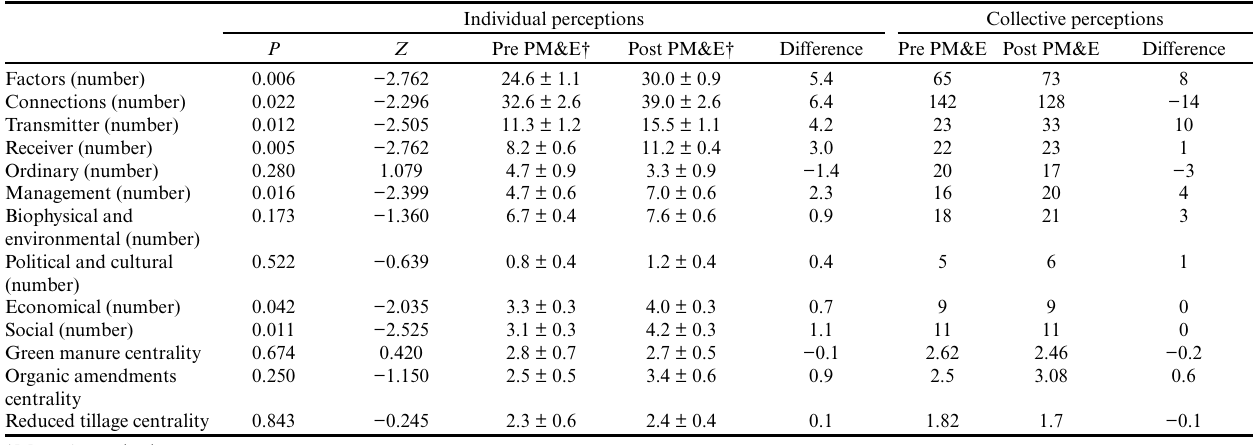
Table 3. Overview results of fuzzy cognitive mapping indices on farmers’ individual and collective perceptions pre and post involvement in participatory monitoring and evaluation (PM&E).